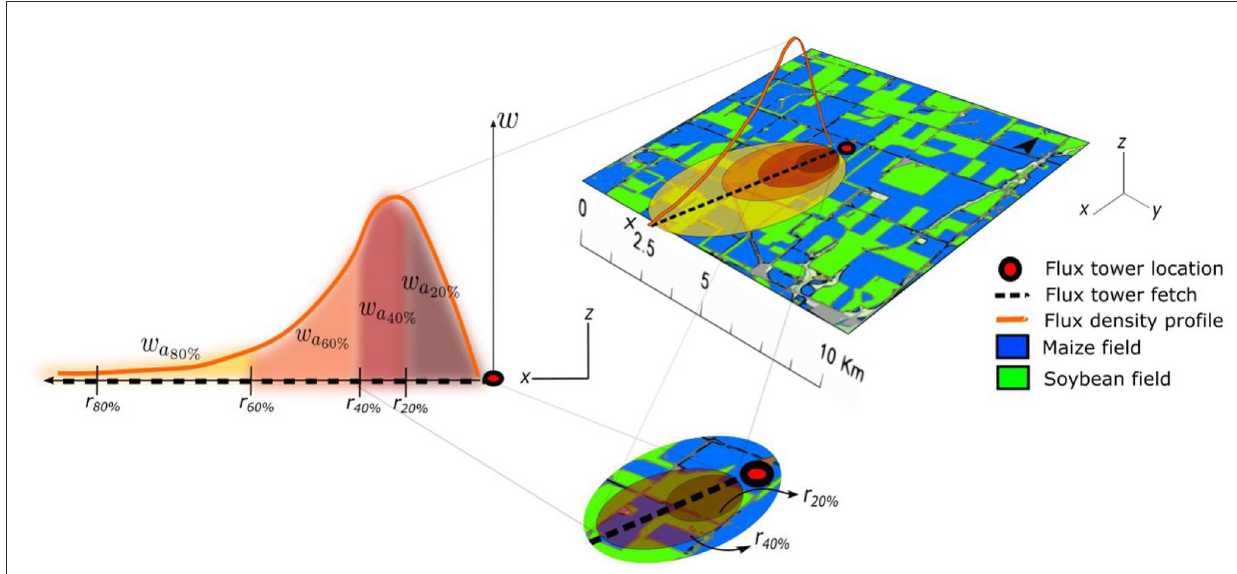
FIGURE3 Illustration of a two-dimensional flux footprint that captures the organized heterogeneity of the maize-soybean mosaic. The land cover data from USDA 2016 (right) shows a mosaic of maize and soybean surrounding the flux tower. The density profile over the mosaic (orange) represents the relative contribution of the flux footprint as a function of the upwind distance, denominated as the fetch (black dashed line). Here we consider explicitly the dependence of the distance of the contributions from different patches. The density profile shows that higher contributions come from locations close to the tower, but not immediately underneath. In the two-dimensional approach (Kljun et al., 2015), the area defined by a set of contours ( r % ) of an increased percentage of contribution (bottom) define the strength and location of the sources/sink areas that contribute to the flux estimated at the tower. w is the weighted flux footprint contribution of each patch of area ( a ) defined by a given contour. Therefore, the flux tower measurement is the combined response of the fields inside the flux footprint (left)